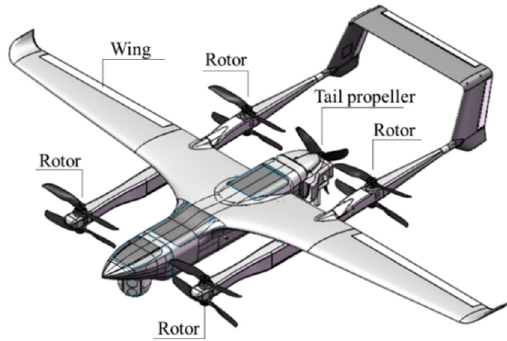
Figure 1. Hybrid wing VTOL UAV.